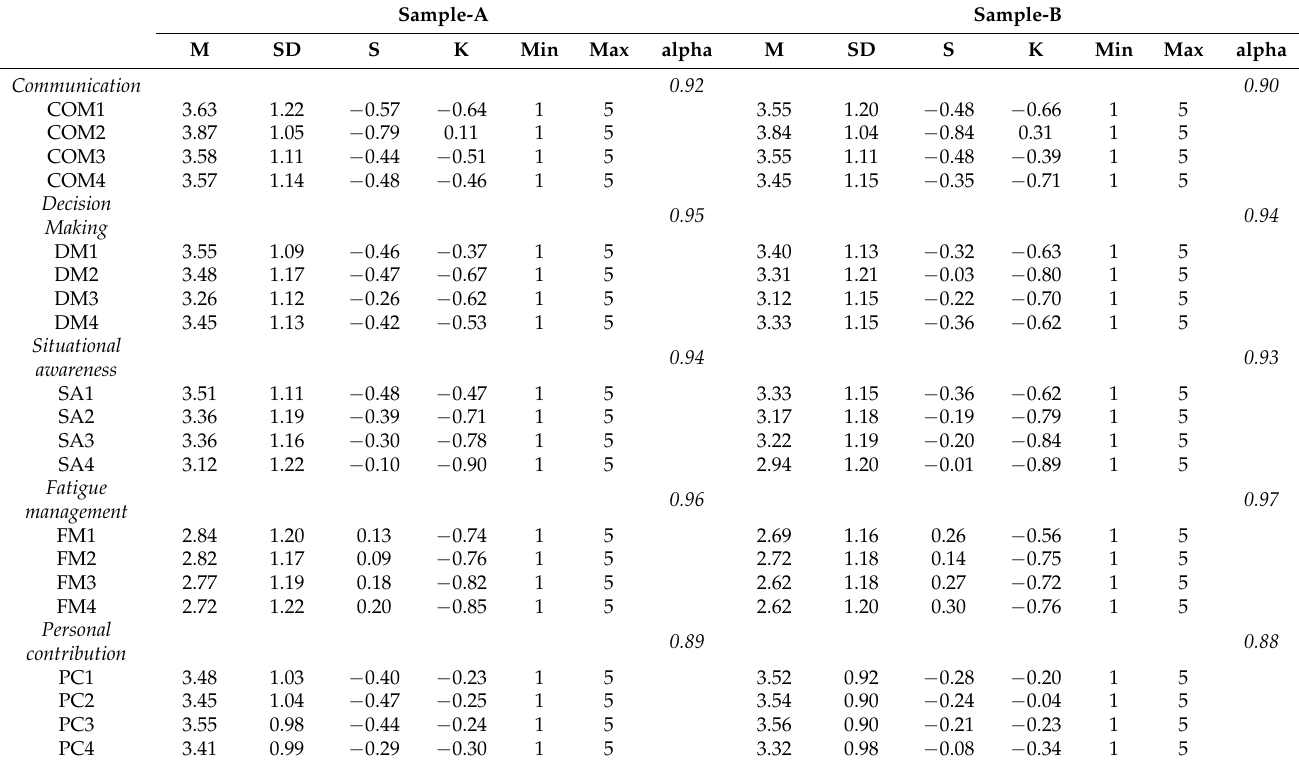
Table 3. SAPH@W scale: item description and scale reliability (Cronbach alpha) by